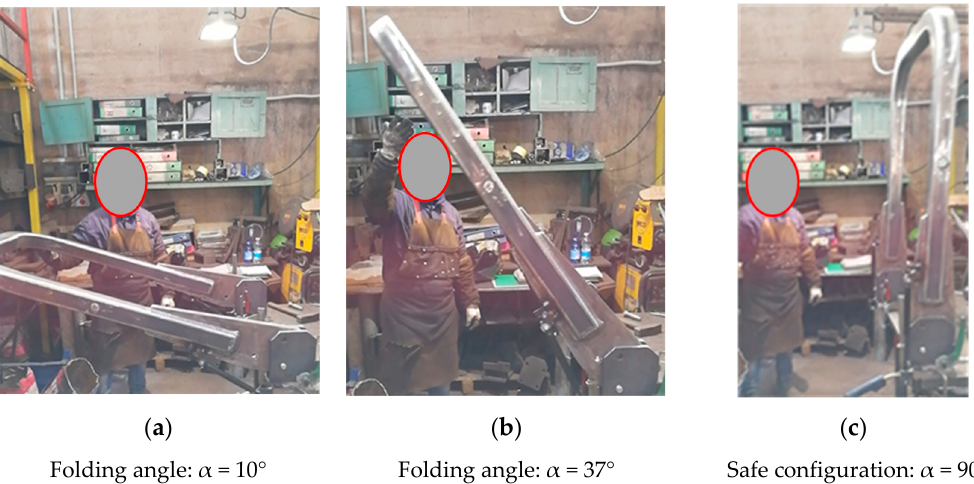
Figure 13. Practical tests concerning the raising operations.